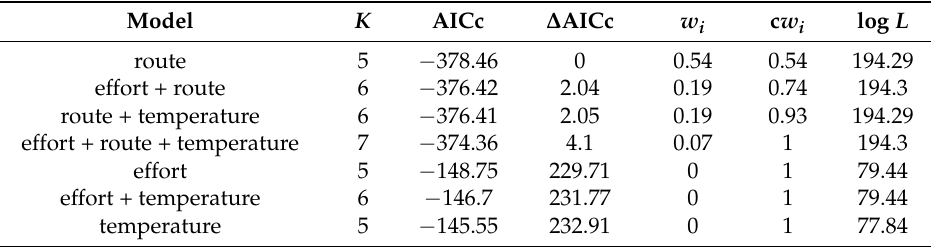
Table comparing the random effects of a priori models of butterfly community composition (NMDS 1) using a constant set of fixed effects, previously chosen to be the best-fit model (Table 1). K = number of parameters in the model, w i = Akaike weights, c w i = cumulative Akaike weights, and log L = log likelihood. Model parameters: “route” is the sample route (A through D), “effort” = duration of the sampling bout in minutes, and